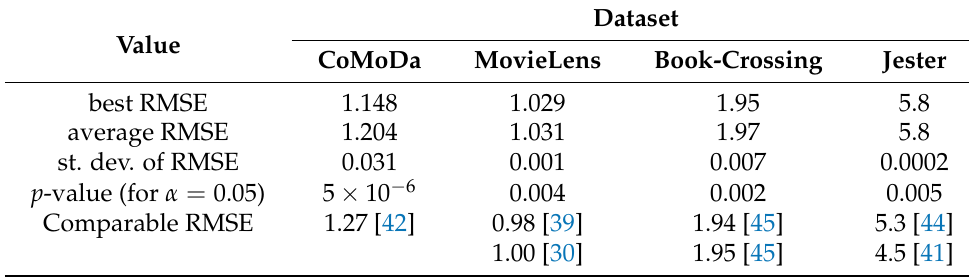
Table 12. Result